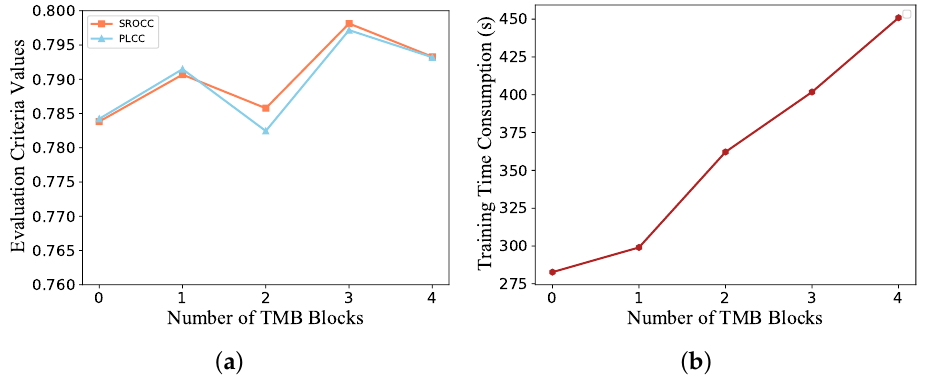
Figure 13. Evaluation of indicators for the selection of TMB. ( a ) Performance indices. ( b ) Training time efficiency on the same